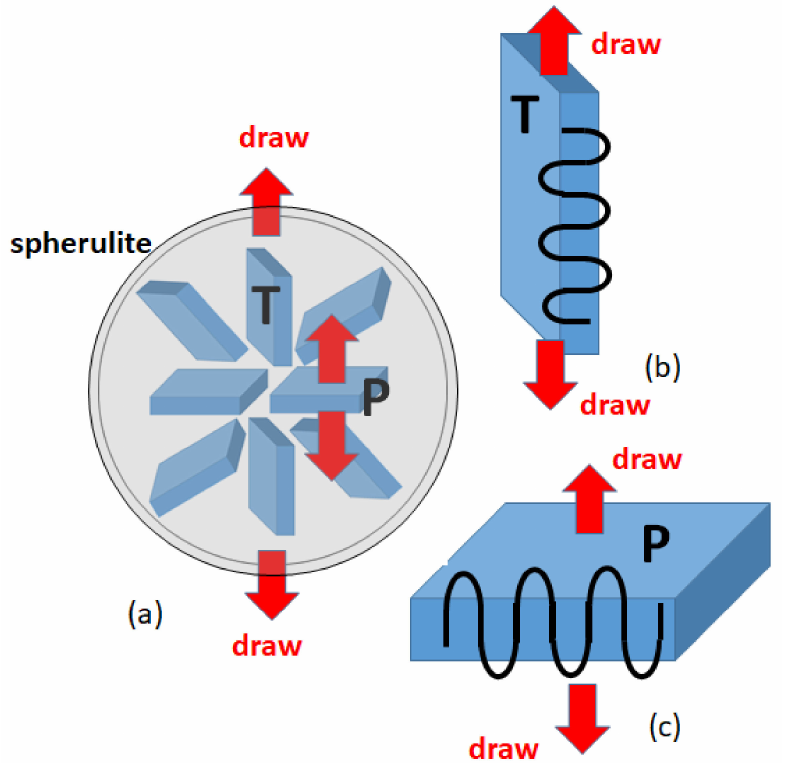
Figure 8. ( a ) Schematic representation of the spherulitic texture of polyethylene, where each lamella is shown as a plate extending along the radial directions; the two representative lamellae are denoted as T-type and P-type. ( b) and ( c ) The mode of lamella deformation is along the directions transverse and parallel to the chain axes for the T-type and the P-type